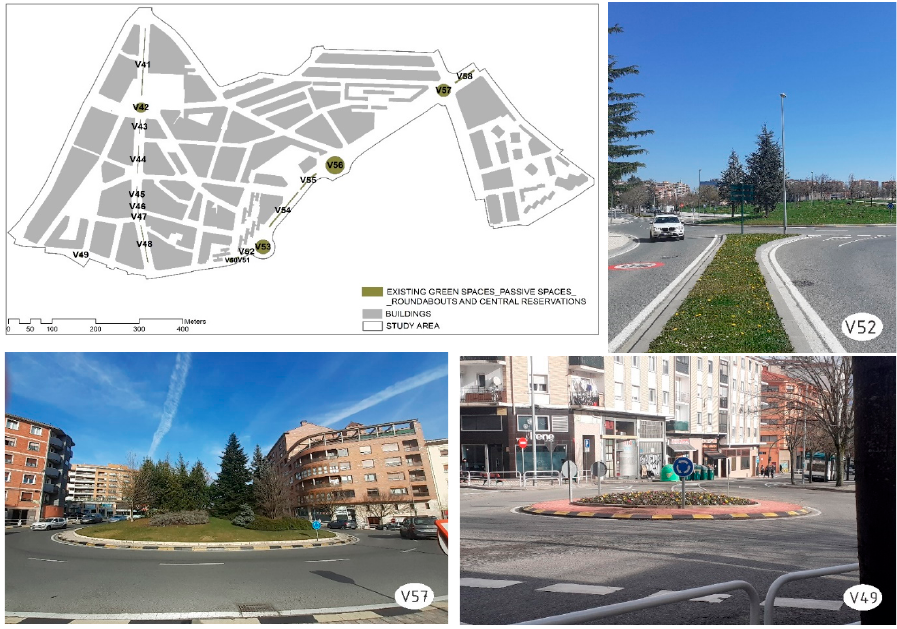
Figure 9. Existing passive green spaces: small gardens in private